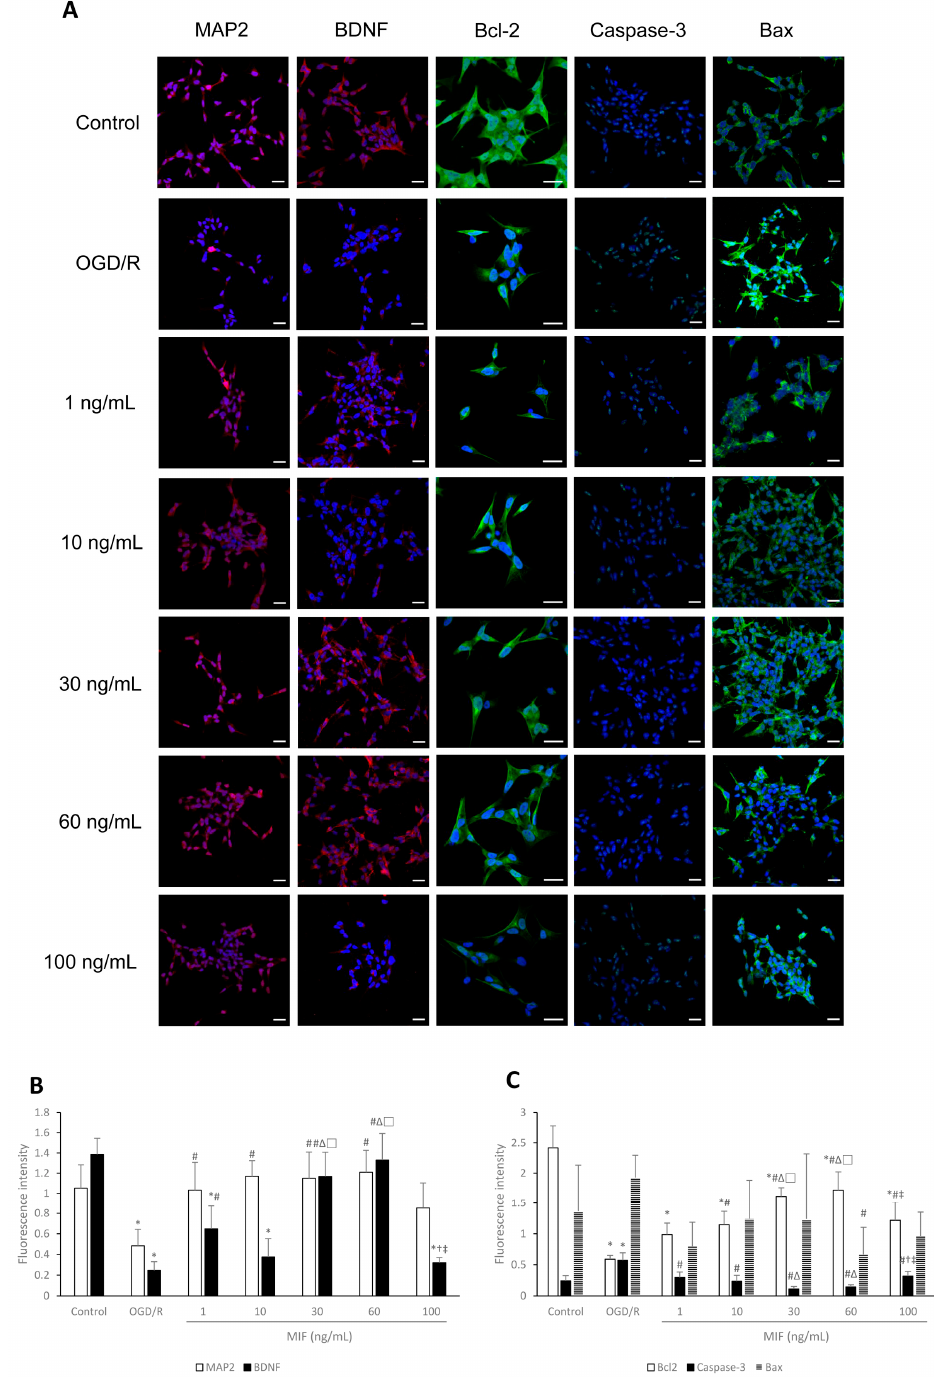
Figure 4. Immunocytochemistry findings of MAP2, BDNF, Bcl-2, Caspase-3, and Bax expression levels under the conditions of control, OGD/R, and OGD/R treated with different concentrations of MIF. ( A ) Representative images of immunocytochemistry for each group; ( B , C ) the expression of MAP2, BDNF, and Bcl-2 was significantly higher in the 60 ng/mL MIF group than in the OGD/R group. The expression of Caspase-3 and Bax was significantly lower in the 60 ng/mL MIF group than in the OGD/R group. Mean ± SD values are presented. * p < 0.05 vs. control; # p < 0.05 vs. OGD/R group; ∆ p < 0.05 vs. 1 ng/mL MIF group; □ p < 0.05 vs. 10 ng/mL MIF group; † p < 0.05 vs. 30 ng/mL MIF group; ‡ p < 0.05 vs. 60 ng/mL MIF group. The differences among the groups were analyzed using one-way ANOVA followed by Tukey’s post hoc test (number of independent cell culture experiments ( n ): all, n = 6) (scale bar, 20 µ m; magnification, 400 × for MAP2, BDNF, Caspase-3, and Bax, or 630 × for